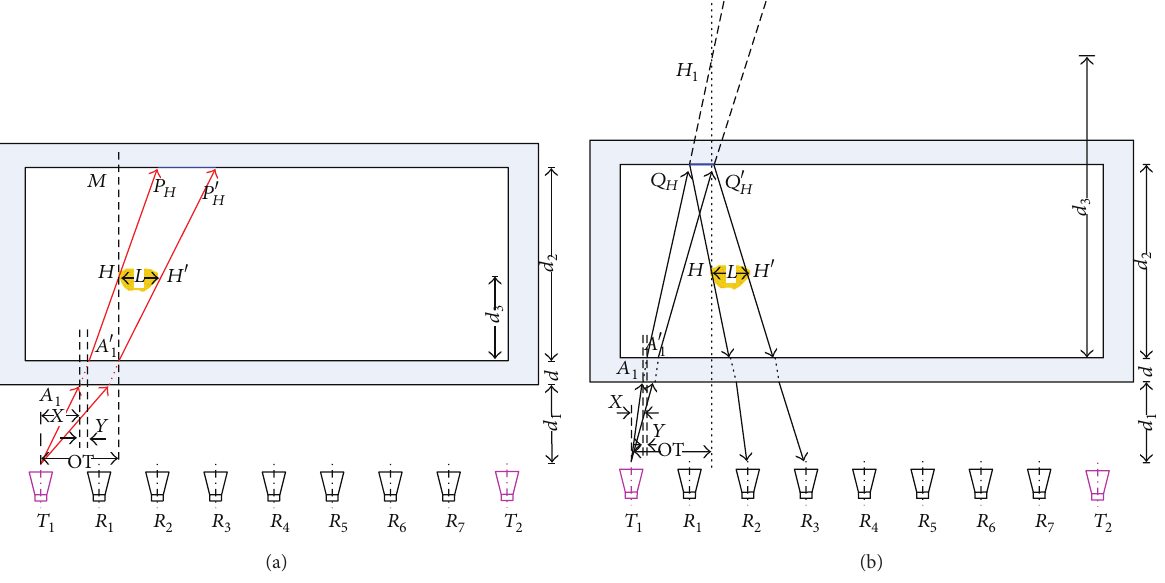
Figure 21: Target obscures the EM propagation in MIMO mode. (a) The first case: obscuring occurs before the back wall reflection. (b) The second case: obscuring occurs after the back wall